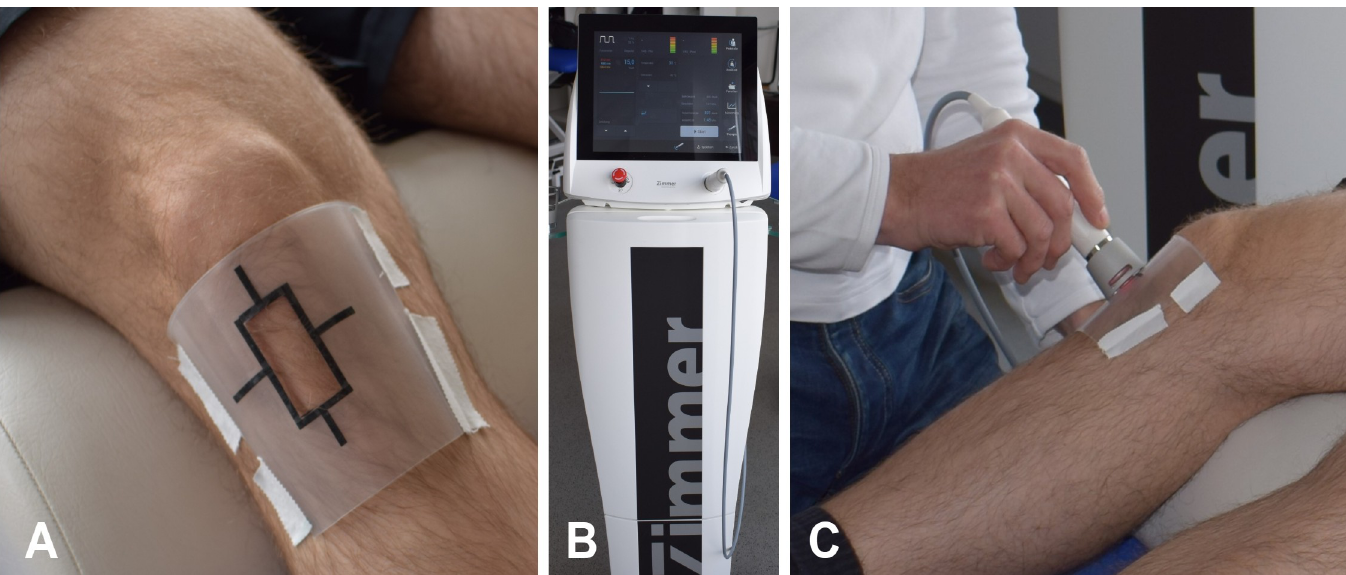
Fig 2. A show the prefabricated template defining the treatment area of 2 cm x 4 cm. B shows the OptonPro high intensity laser therapy device. C shows the laser application to the patellar tendon.